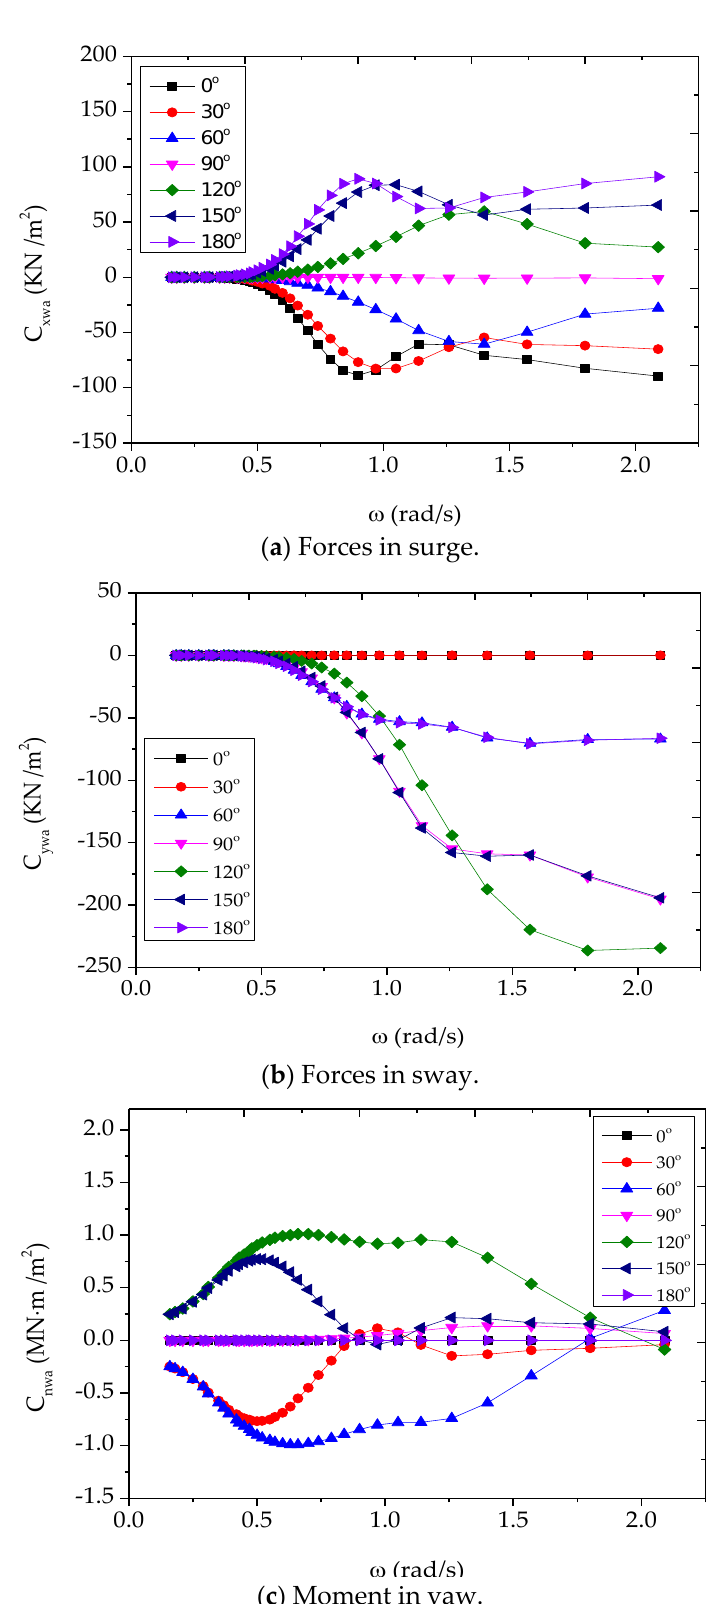
Figure 7. Second-order wave force transfer function. ( a ) Forces in surge, ( b ) forces in sway, ( c ) moment in yaw.